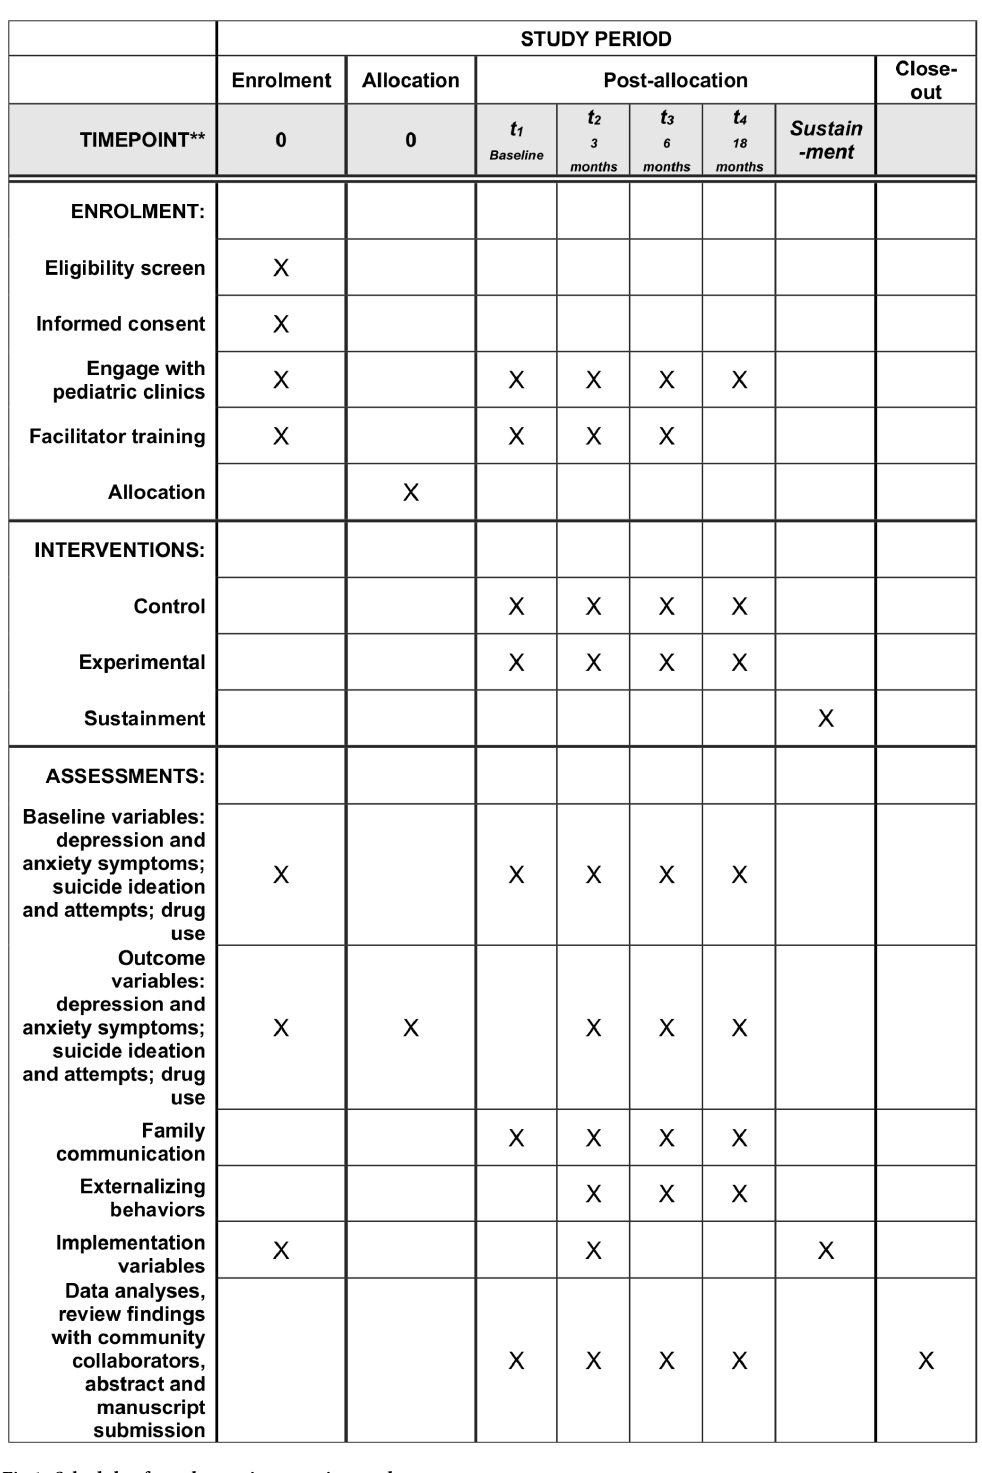
PLOS ONE | https://doi.org/10.1371/journal.pone.0283987 April 18,